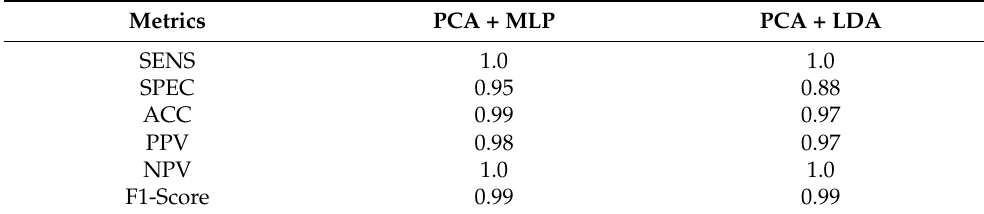
Table 2. Classifier performance comparison for characterization of Raman spectra of healthy (HTo) and asymptomatic infected plants